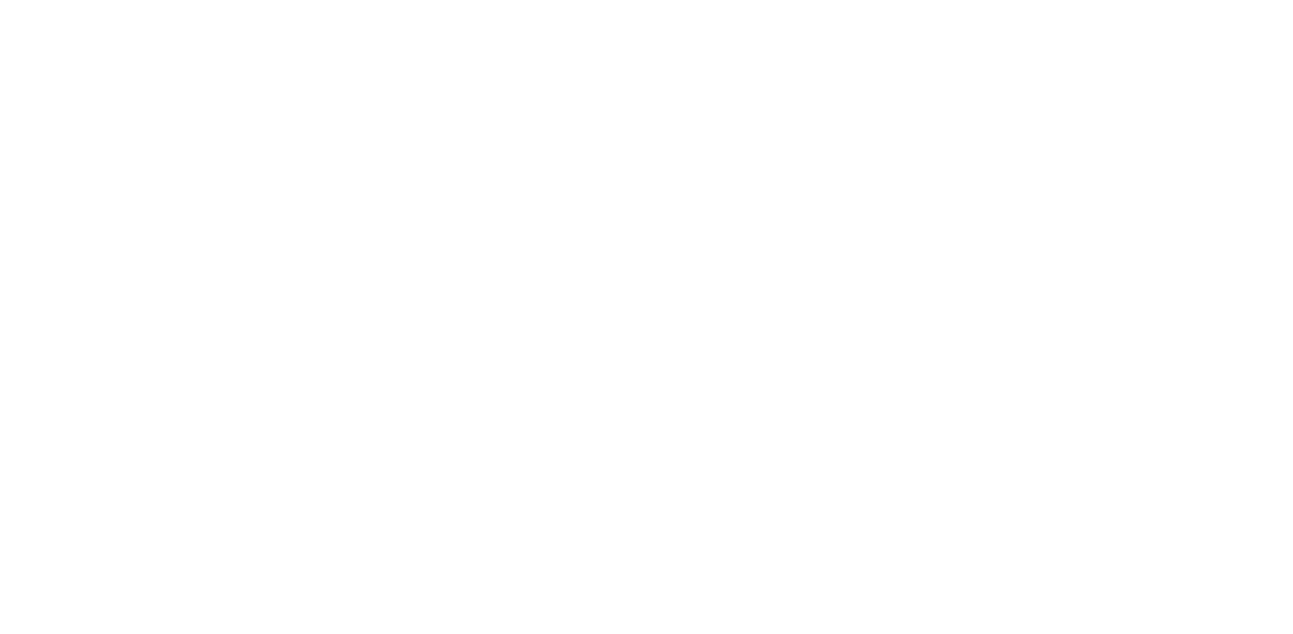
Frontiers in Earth Science | www.frontiersin.org